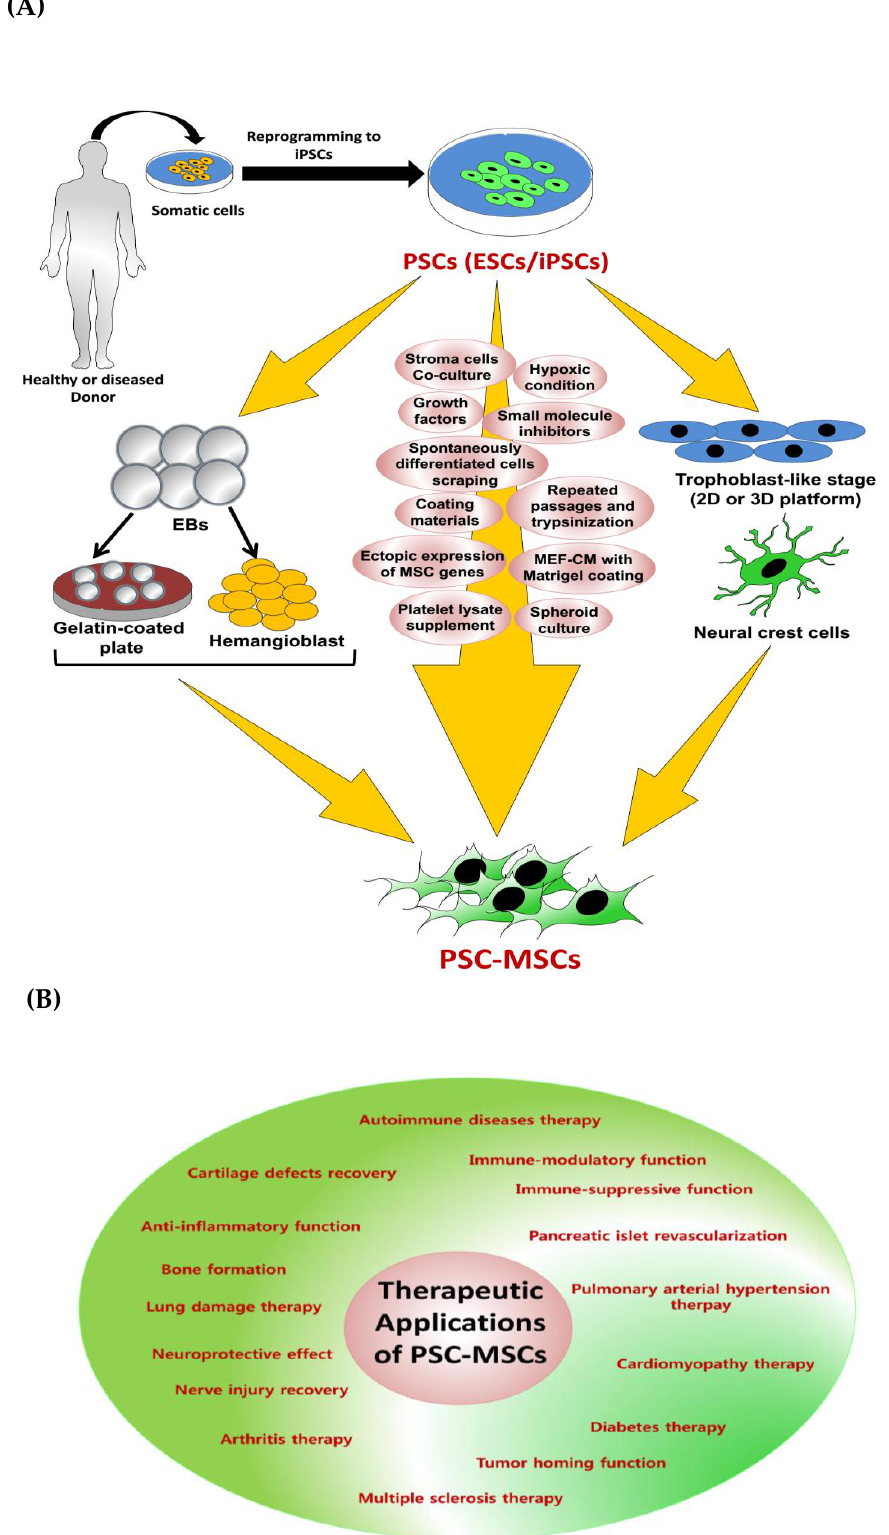
Figure 7. Schematic diagram outlining the methods for pluripotent stem cells-derived mesenchymal stem cells (PSC-MSCs) production and their therapeutic applications. ( A ) Methods for the production of PSC-MSCs. ( B ) The therapeutic applications of PSC-MSCs in various diseases.